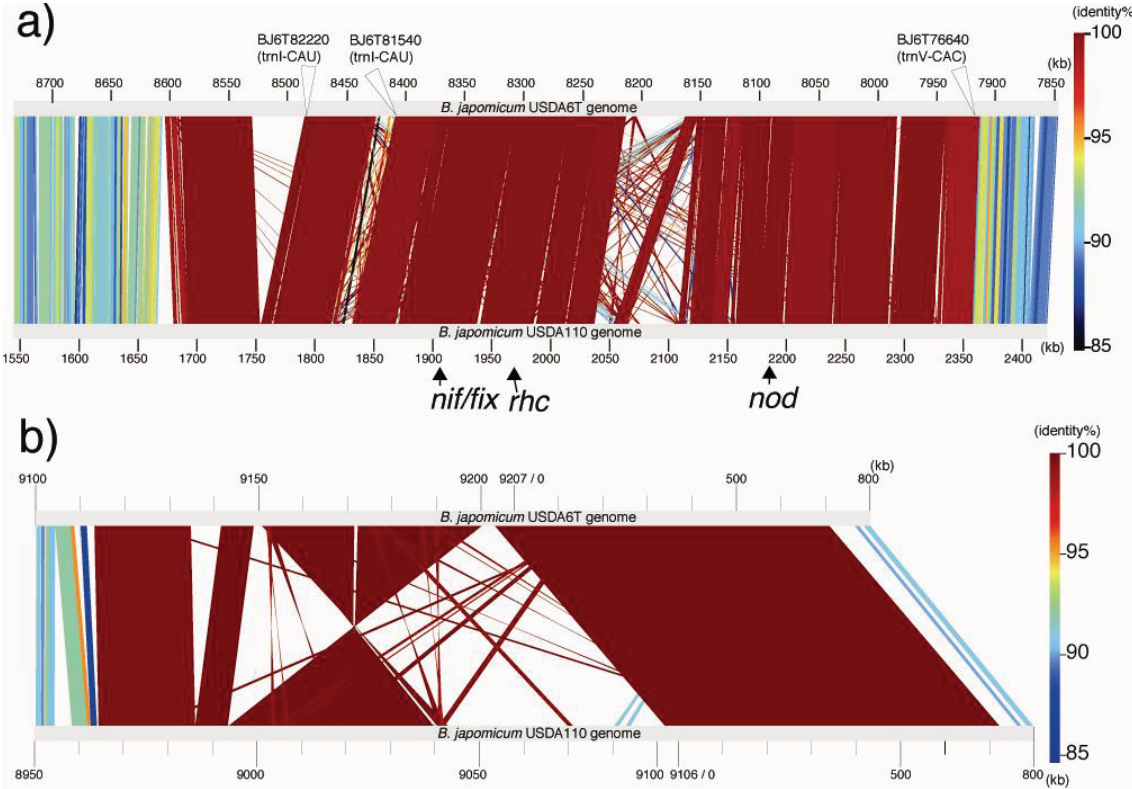
Figure 4. Percent identity plot between USDA110 and USDA6 T genome sequences. ( a ) Linear pairwise comparison of regions corresponding to “Locus A” containing “distinct identic al genes” from the two genomes. The gray horizontal bars (with a scale corresponding to each genome sequence position), represent the reverse strand of the USDA6 T genome and the forward strand of the USDA110 genome. Regions with alignment up to an E-value of 10 − 4 are represented by highlighted connecting colored lines between USDA6 T and USDA110. Colors indicate the % nucleotide identity in the alignment output by BLASTN, according to the vertical scale on the right. Open triangles indicate the positions of tRNA genes on the genome. Arrowheads indicate the locations of gene clusters involved in symbiosis or nitrogen fixation; ( b ) Linear pairwise comparison of regions corresponding to the “Locus C”